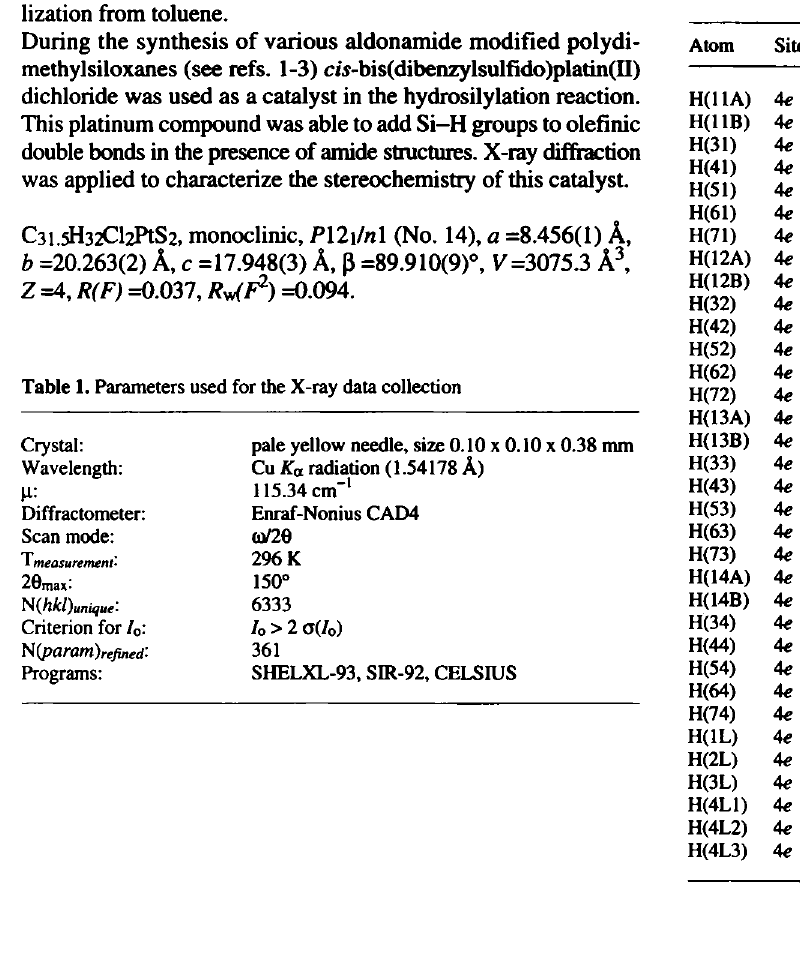
Table 2. Final atomic coordinates and displacement parameters (in